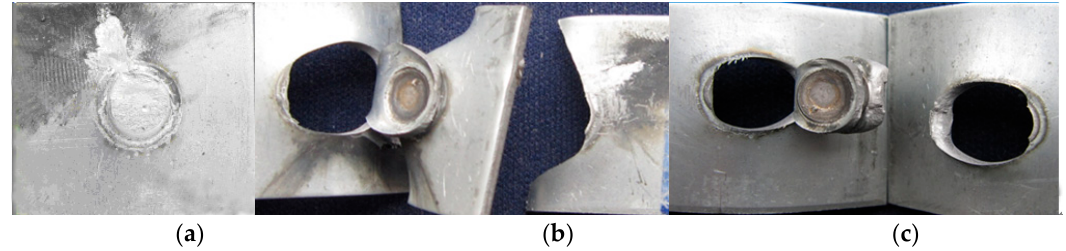
Figure 14. Three failure modes of the resistance spot welded joints: ( a ) Interface failure; ( b ) pullout failure (base metal tear fracture); ( c ) pullout failure (pullout tear fracture).